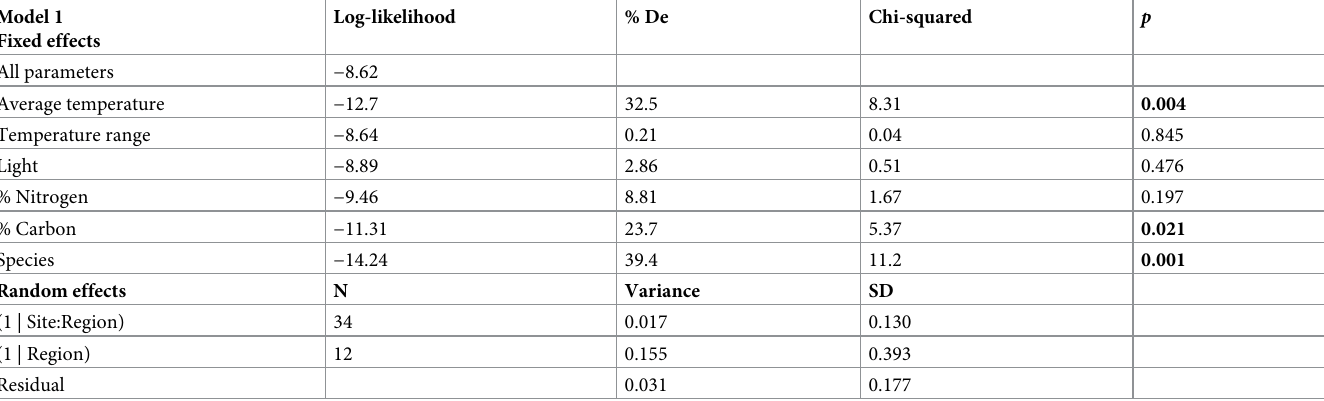
Table 1. Generalized linear mixed-effects models. GLMM relating the decomposition (% d − 1 ) of kelp detritus to environmental conditions and tissue properties at 12 regions of the northern hemisphere. Temperature (average and range) is temperature at the seafloor over the duration of the experiment. Light is scaled average light (Lux) over the first 2 weeks of the experiment. GLMMs are with gamma distribution and identity link function with predictors temperature (range, average), light and species, initial % carbon and % nitrogen content. Importance of fixed effects parameters were evaluated using likelihood ratio tests with single-term deletions. Shown for each dele- tion are percentage of deviance explained (% De) and chi-squared statistic used to compare model with deletion to full model. Site and region represent random effects ( n = 12